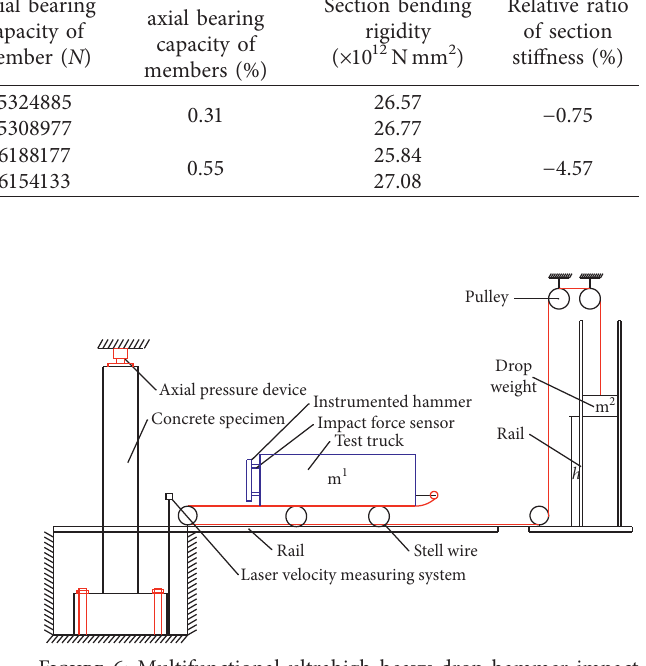
Table 5: Comparison of the equal-strength replacement of the pier specimens. Specimen Group